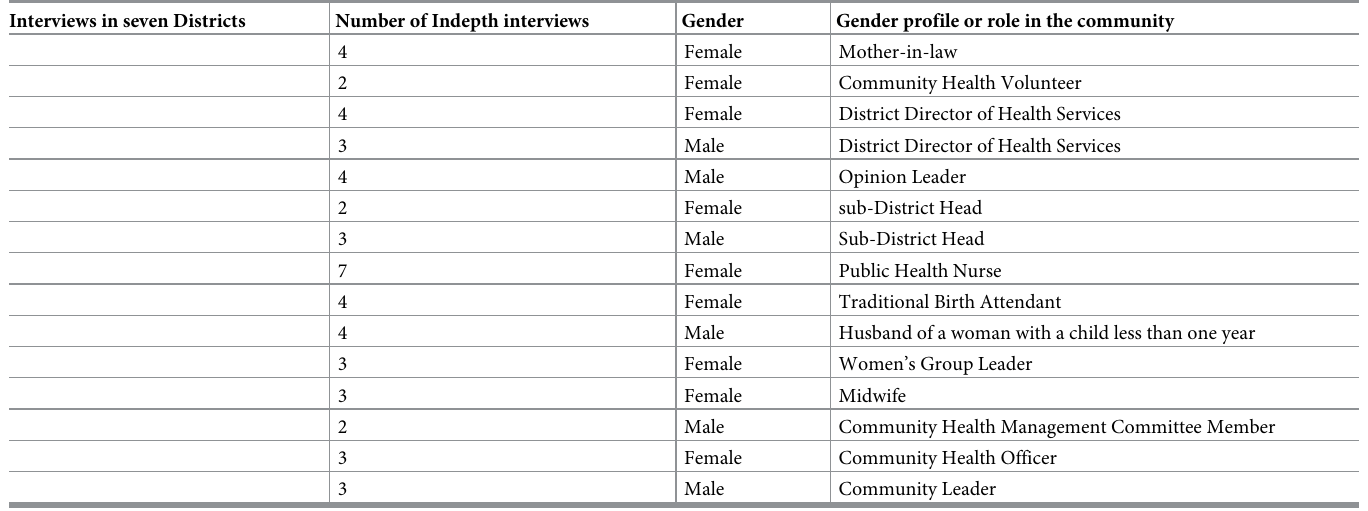
Table 3. Demographic characteristics of IDI participants, Upper East region 2017.